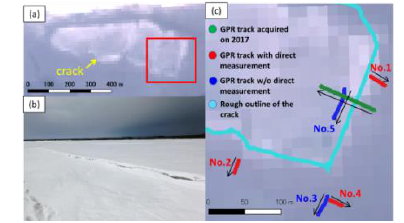
Figure 3. Test field located in the west side of the lake. (a) Sattellite image taken by Sentinel-2 (Jan. 18 th , 2018). (b) Crack arround the area. (c) GPR survey line arround the rectanguler in (a). The arrows indicate scan direction.